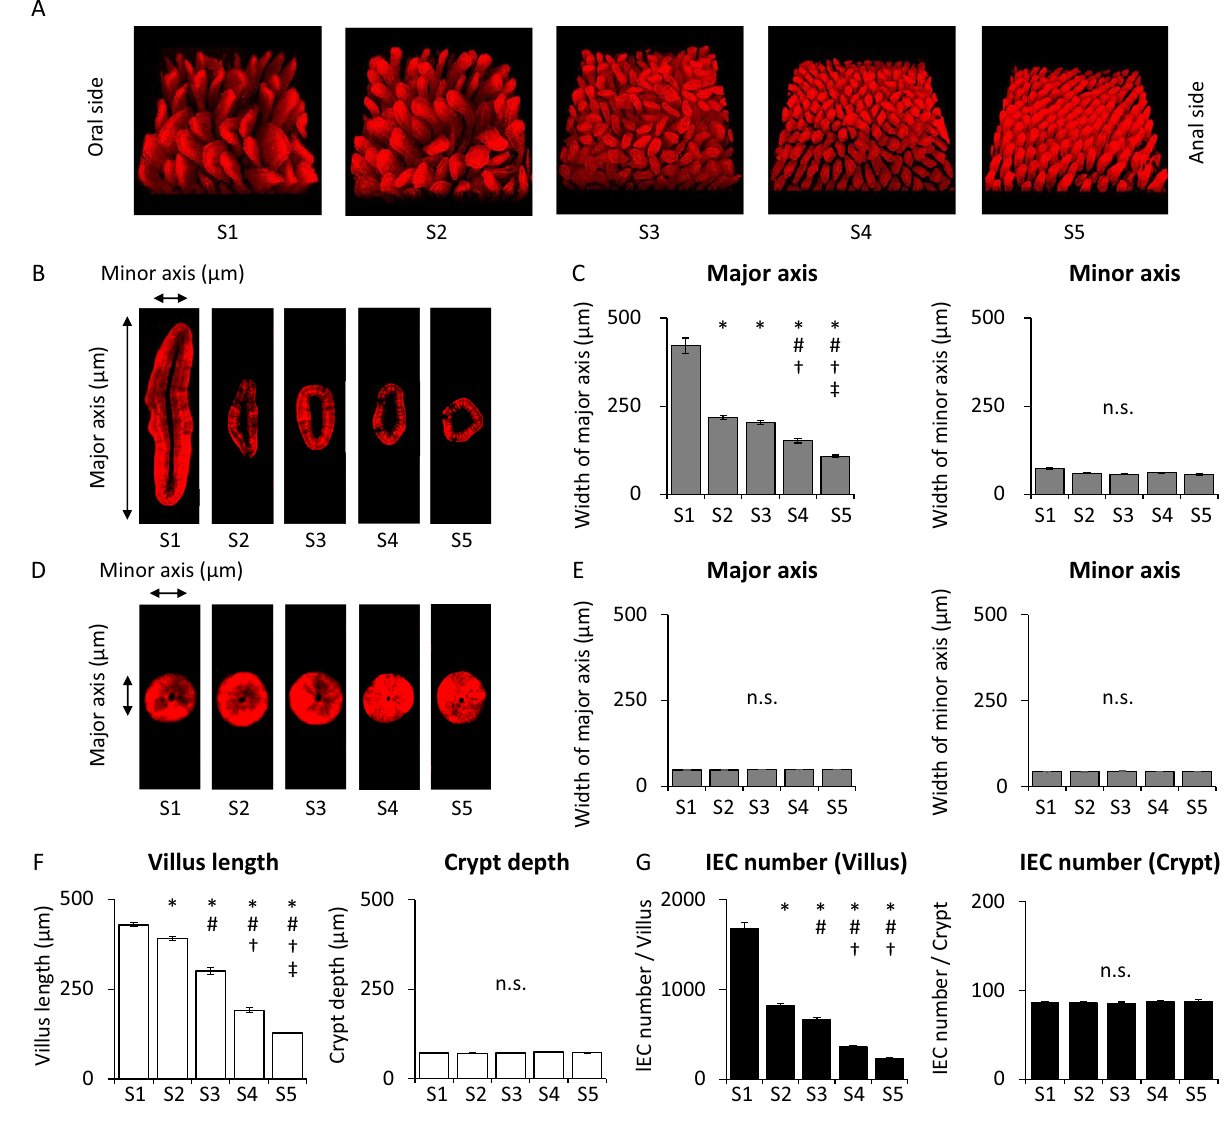
Figure 1. Morphology and analysis of the small intestine in Villin1-Tomato mice. ( A ) The whole images of small intestine and the cross section of ( B ) villi and ( D ) crypts. Width of ( C ) villus and ( E ) crypt major axis and minor axis, ( F ) villus length and crypt depth, and ( G ) intestinal epithelial cell (IEC) number per villus or crypt of each section in small intestine (n = 50 villi or 50 crypts in 5 mice). *P < 0.05 vs. S1, # P < 0.05 vs. S2, † P < 0.05 vs. S3, ‡ P < 0.05 vs. S4. n.s. not